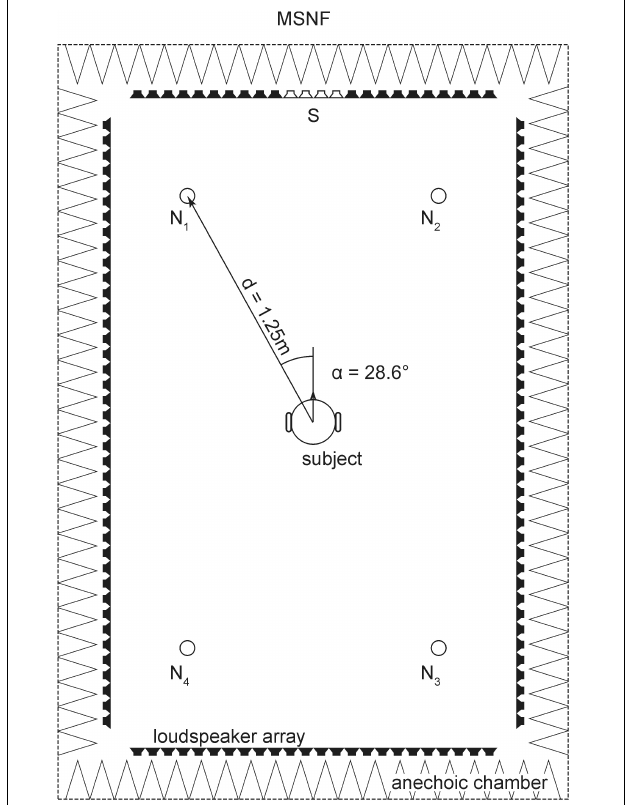
FIGURE 1 | Loudspeaker array with 128 independent loudspeaker channels in rectangular shape mounted in the horizontal plane at 1.20 m for measurement of speech perception in noise. The speech signal (S) was generated from front loudspeakers in the 0 ◦ -position. Four virtual noise sources (N1-4) for multi-source noise field (MSNF) were created by wave field